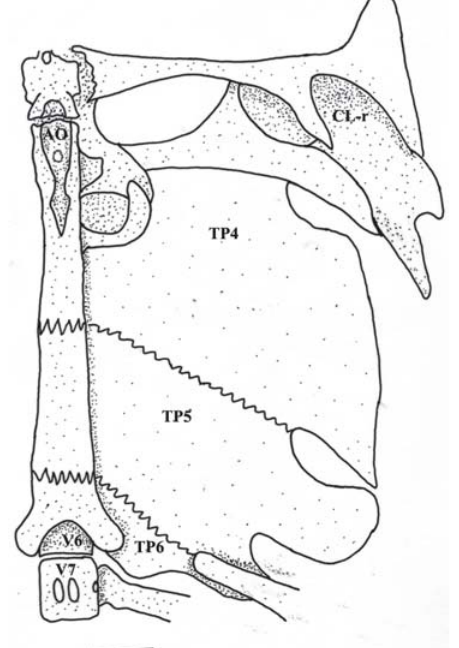
Fig. 5. Pimelodus halisodous , UNT 3438, 98.9 mm SL. Ventral view of left side of Weberian complex, basioccipital region and upper shoulder girdle. AO = aortic groove; CL-r = “cleithral ring”; TP4-6 = transverse process of vertebrae 4 to 6; V6-7 = vertebrae 6 and 7. Scale bar = 1 mm.